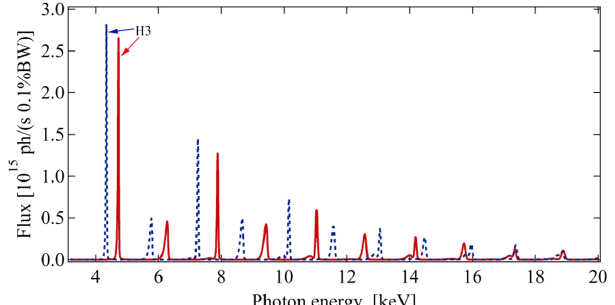
FIG. 15. U18 spectrum calculated with SRW code at a distance of 17 m from the source point through a slit of 0 . 1 mm × 0 . 1 mm at minimum gap of 5.5 mm. (Solid line) At room temperature of 293 K, (dashed line) at cryogenic temperature of 77 K. Beam